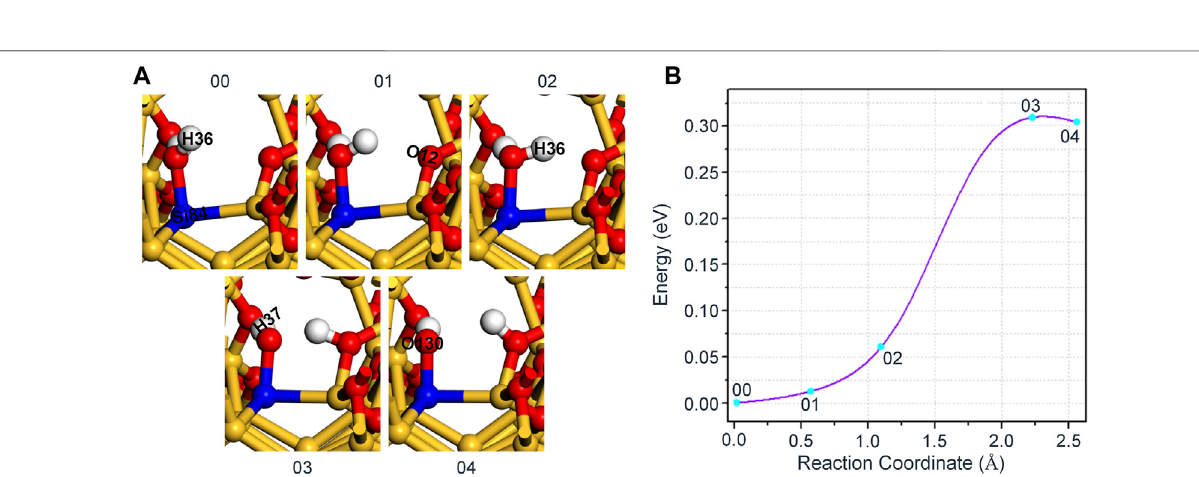
FIGURE 6 | (A) The schematic diagram of the reaction between P b1 defect and H 2 O. (B) The variation of the energy with different reaction coordinates for the reaction of H 2 O and P b1 defect with AOD con fi guration at random position 2.